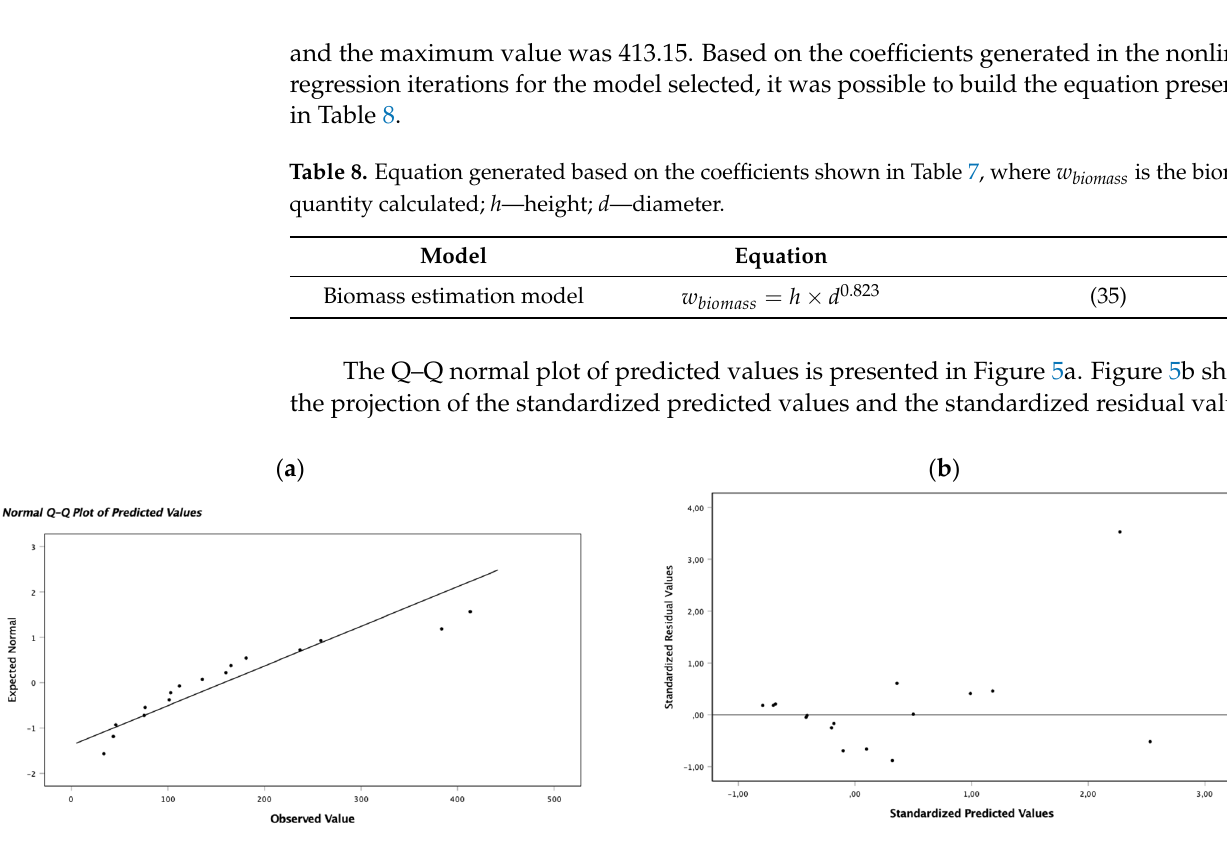
Figure 5. ( a ) Normal Q–Q plot of the predicted values; and ( b ) standardized predicted values and standardized residual values.